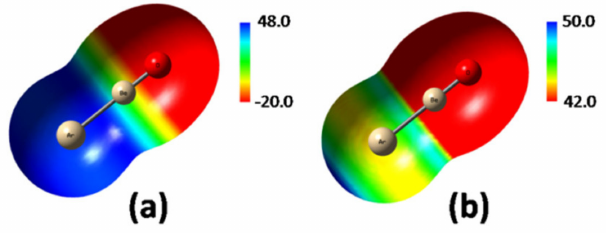
Figure 6. MP2/aVTZ MEP (0.0010 ea 0 − 3 isodensity surface) of ArBeO plotted using a wider ( a ) and narrower ( b ) scale (values in kcal mol − 1